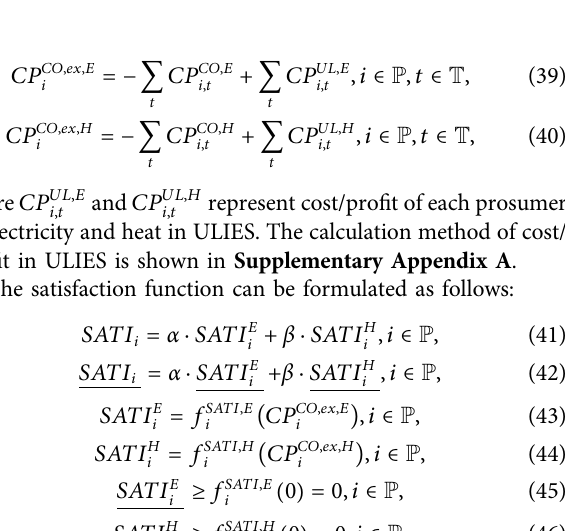
FIGURE 3 | Shapes of satisfaction function. (A) Function 1 and (B) function